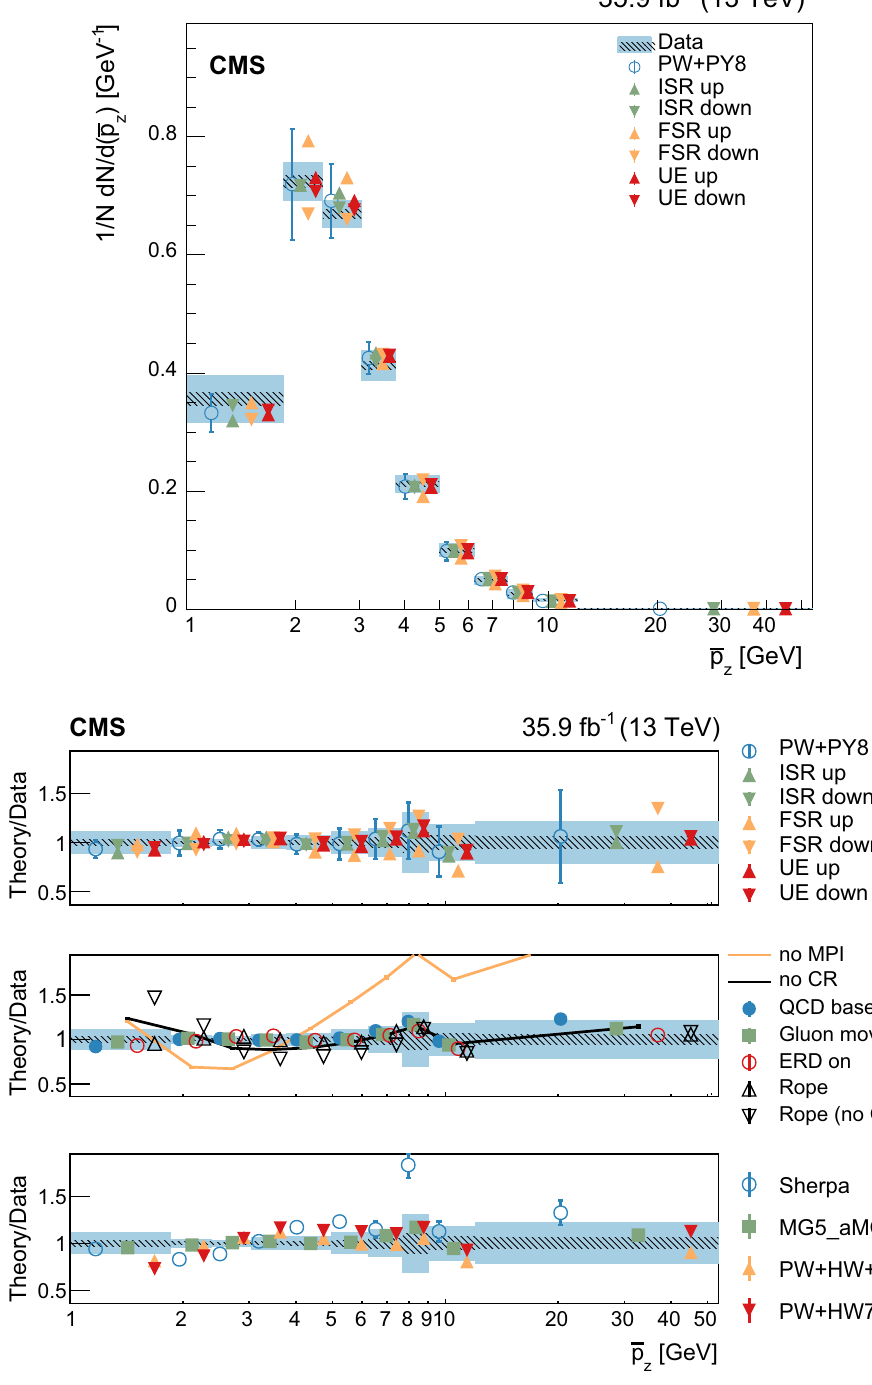
Fig. 9 Normalized differential cross section as function of p z , compared to the predictions of different models. The conventions of Fig. 4 are